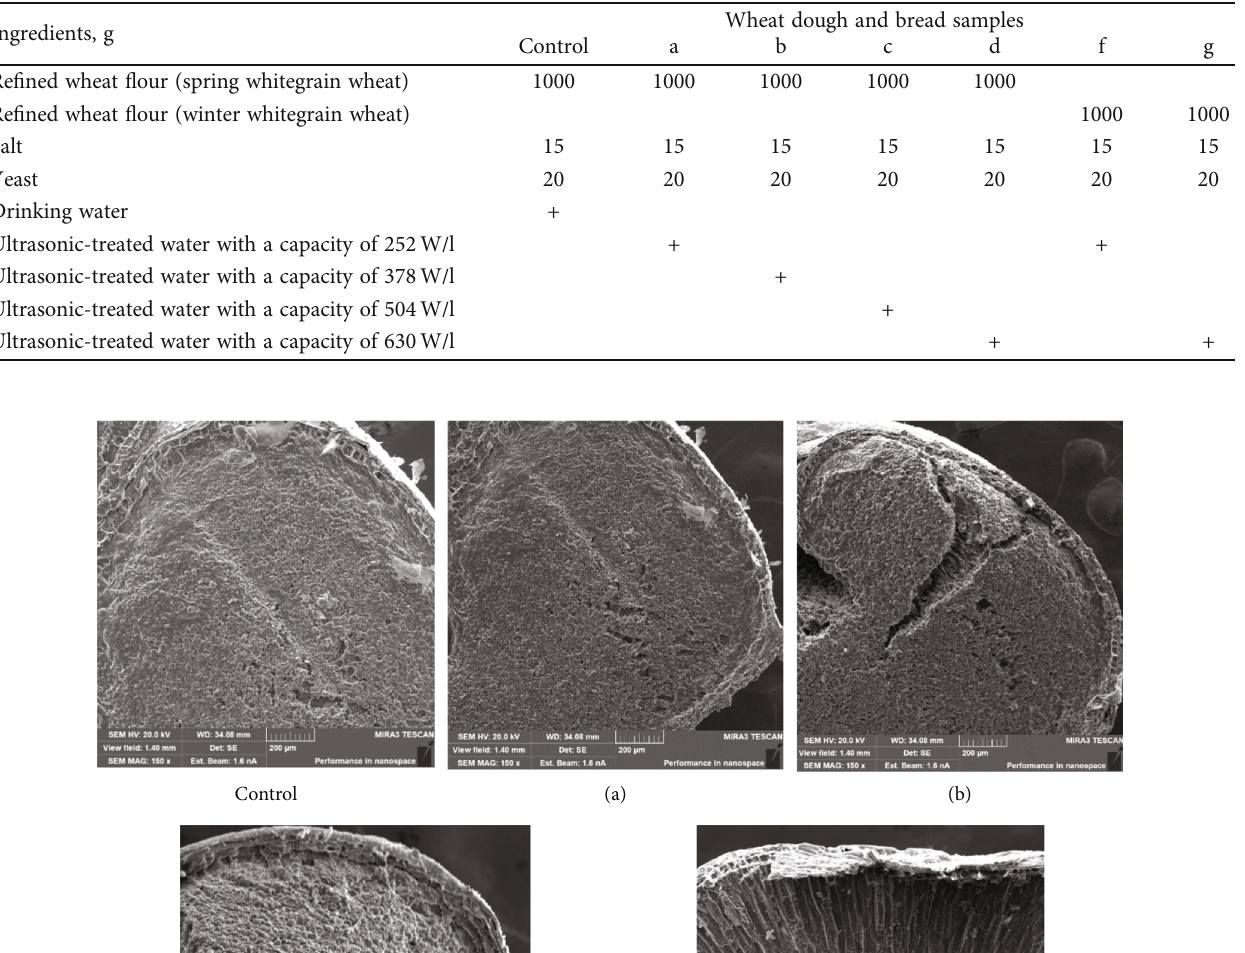
Table 1: The formulations of dough.